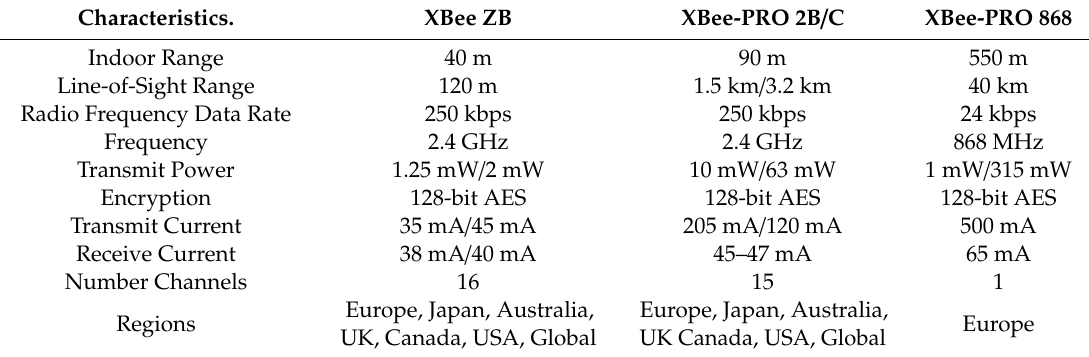
Table 1. ZigBee device characteristics comparison